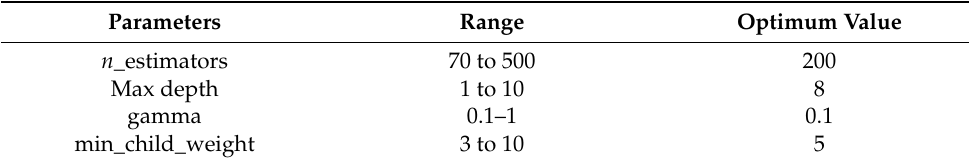
Table 5. The grid search XGBoost regression modeling hyperparameters.